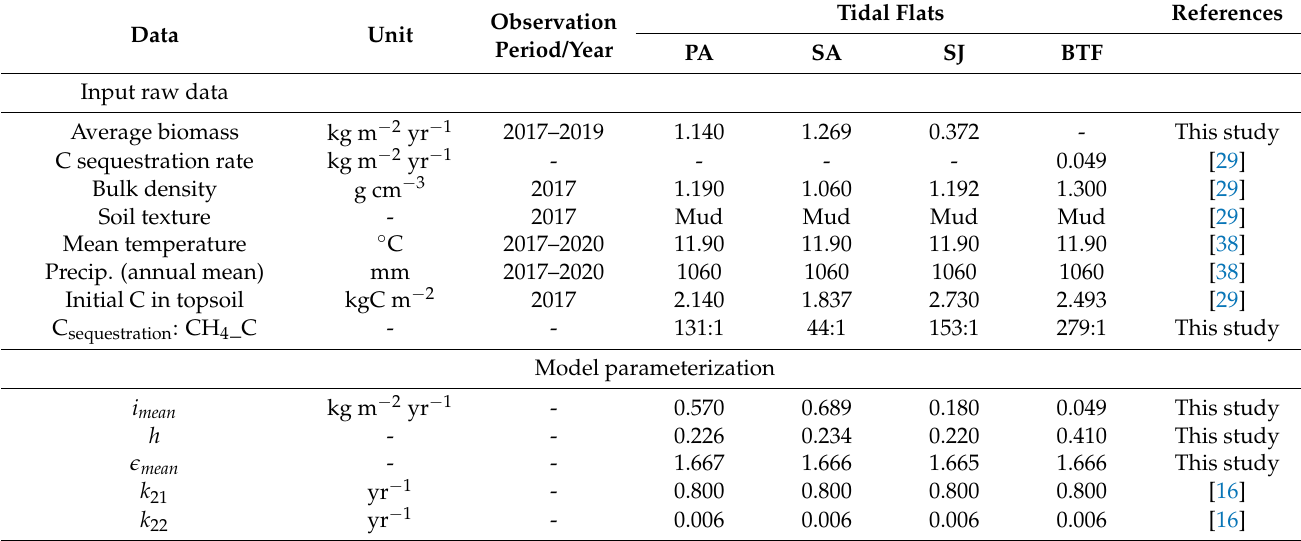
Table 1. The input data and parameter values used in the GHG emissions model from tidal flats– Phragmites australis (PA), Spartina alterniflora (SA), Suaeda japonica (SJ), and Bare Tidal Flat (BTF) in Ganghwa,